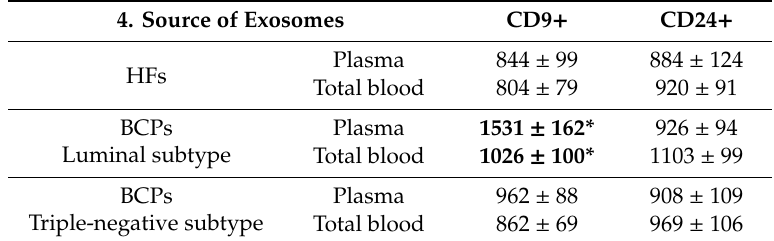
Table 8. Expression of CD9 and CD24 on the Surface of ADAM-10 Positive Exosomes from Plasma and Total Blood of HFs and